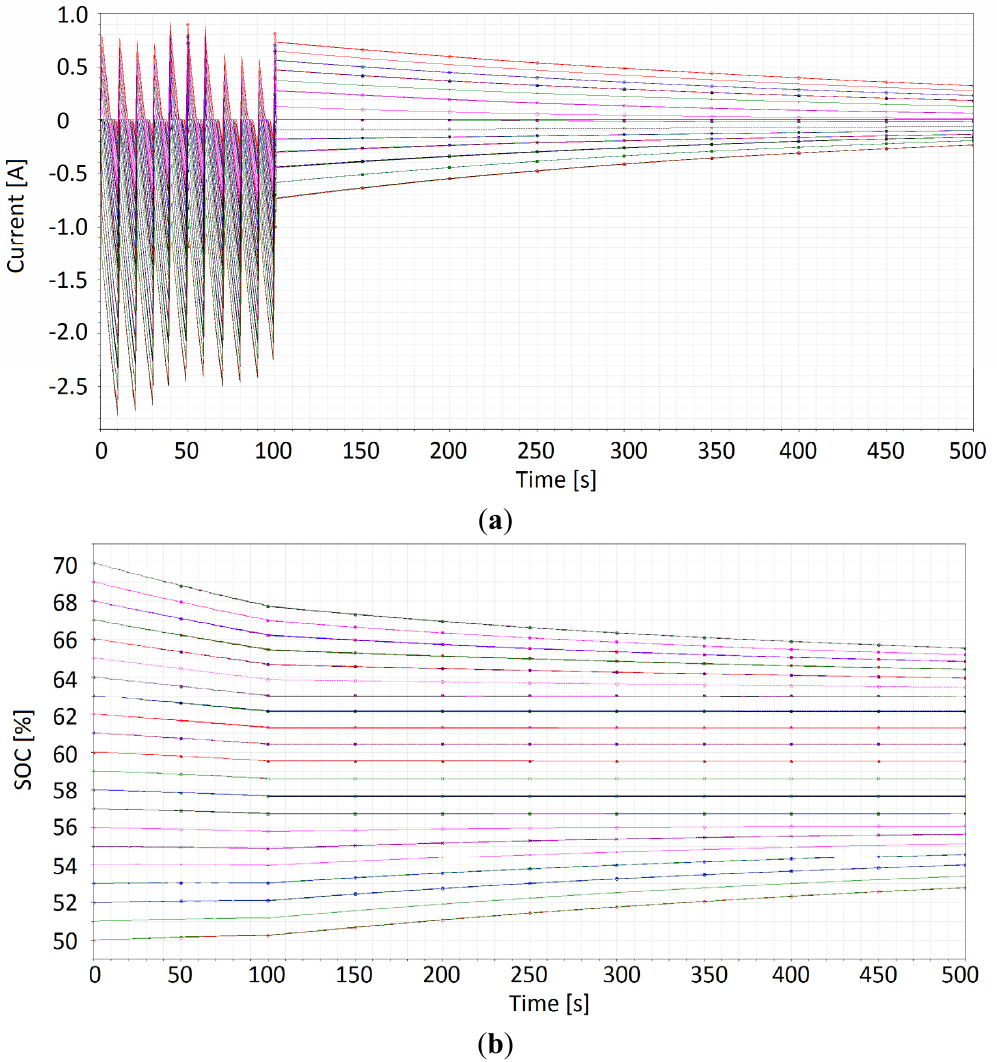
Figure 13. ( a ) Current (A) vs. time (s) for an 81p1s module with randomly assigned initial ≤ 70; and ( b ) SOC (%) vs. time (s) for an 81p1s SOC in the range of 50 ≤ SOC initial